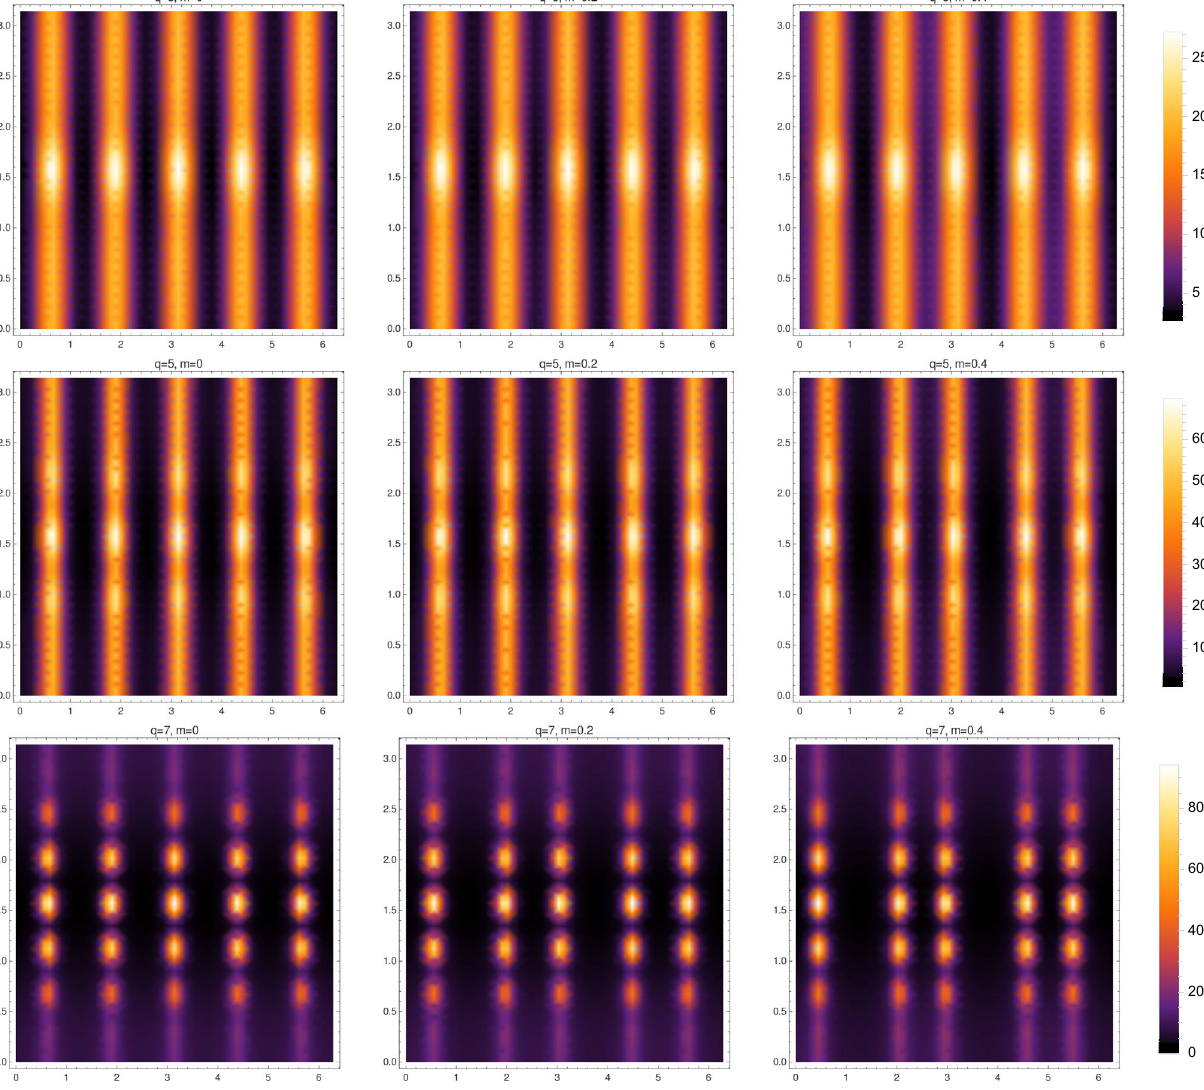
Fig. 3 Comparison of the energy density for different configurations with topological charge B = 5, as function of q and m . Here we have considered n = 5, K = 2, L = 1 . 05 and p =